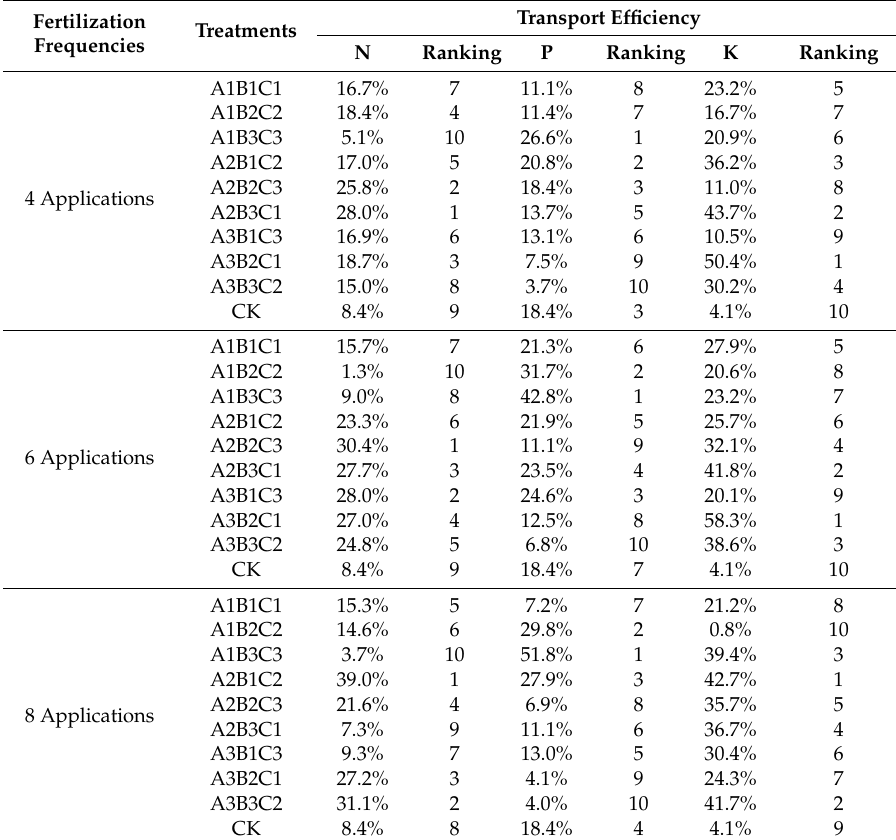
Table 11. Effects of different fertilization ratios and frequencies on transport efficiency.